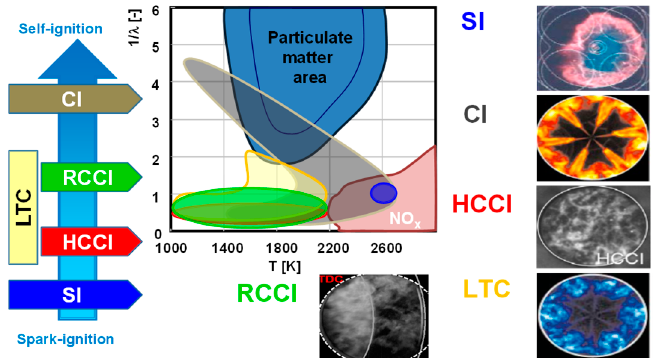
Figure 1. Modern combustion systems and the possibilities of reducing exhaust emissions [12–14].